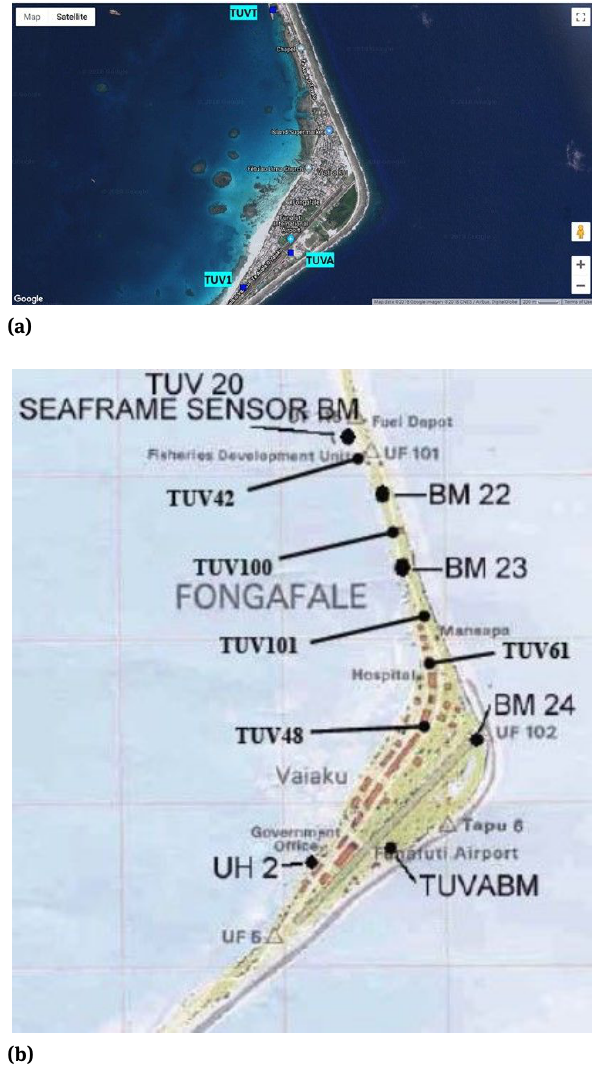
Figure 10: a) Location of the GPS antennas of TUVT, TUVA, and TUV1 in Funafuti. Image modified after NGL; b) location of the FUGAFUTI B tide gauge and leveling benchmarks. Image reproduced, modified after